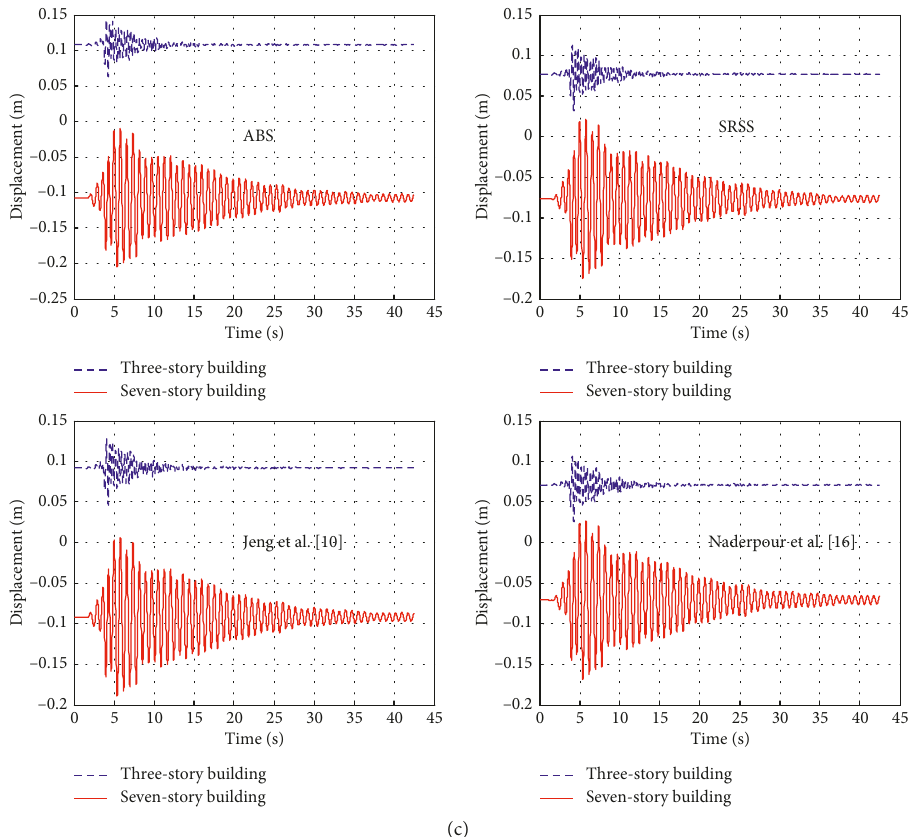
Figure 3: The lateral displacements of two buildings with gap size calculated by different methods for different earthquake records (elastic buildings). (a) Kobe earthquake. (b) Loma Prieta earthquake. (c) Parkfield